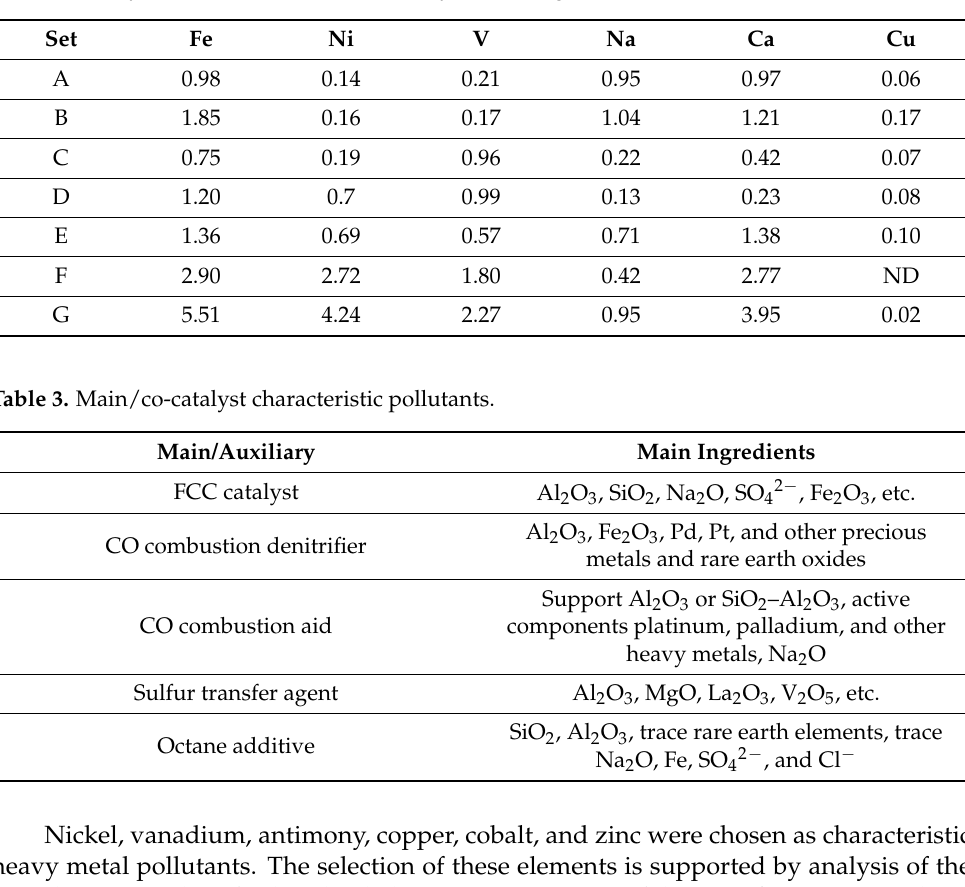
Table 2. Heavy metals concentrations in catalytic cracking feedstock oil.